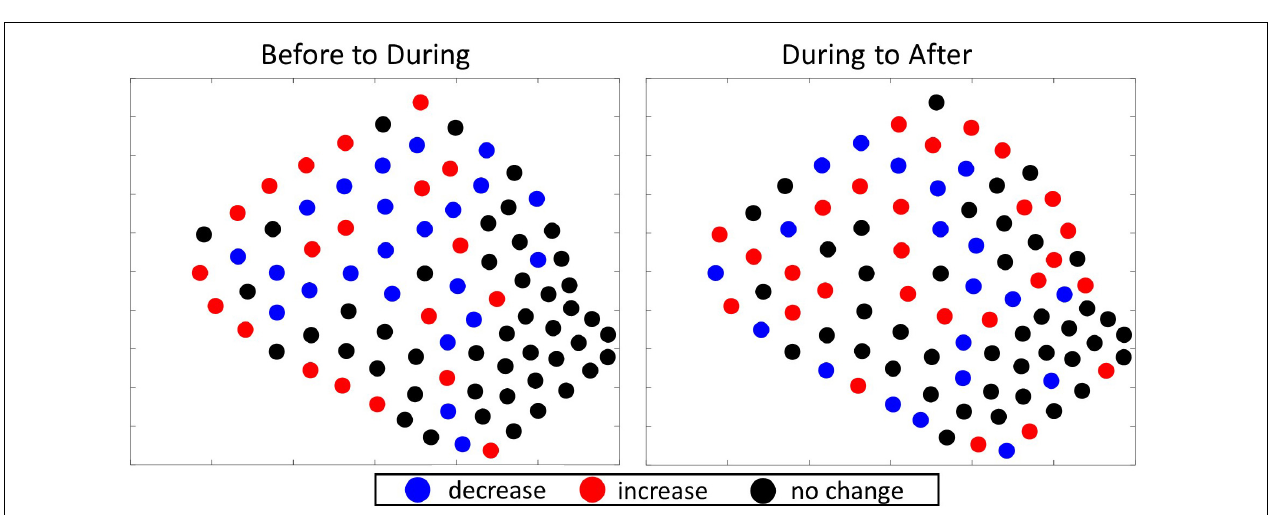
FIGURE 5 | Difference plots showing the direction of change in the number of GVPs per hydrophone from one period to the next of the 2017 survey. Left : difference plot showing change from Before to During ; Right : difference plot showing change from During to After